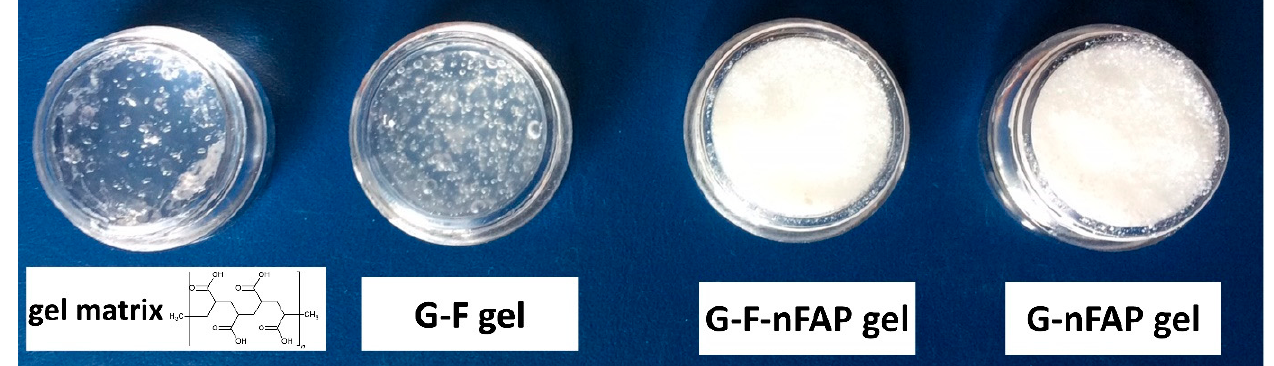
Figure 7. The hydrogel formulations based on a 1.5% w/w Carbopol matrix and the structure of the Carbopol polymer.